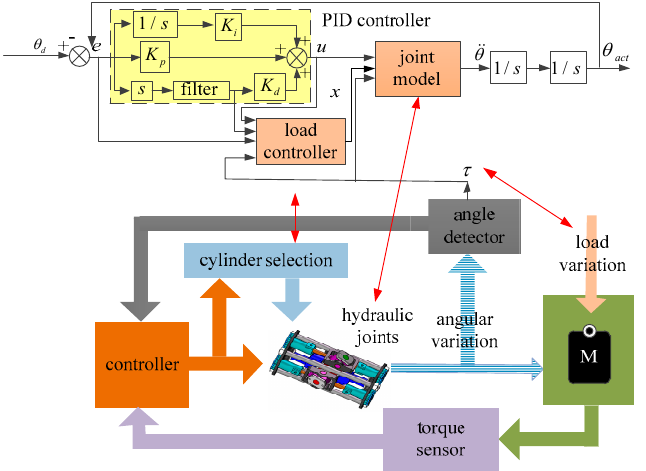
Figure 11. Diagram of a hydraulic joint control system.